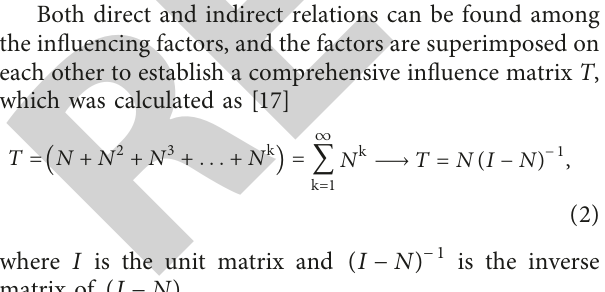
Figure 1: Relation